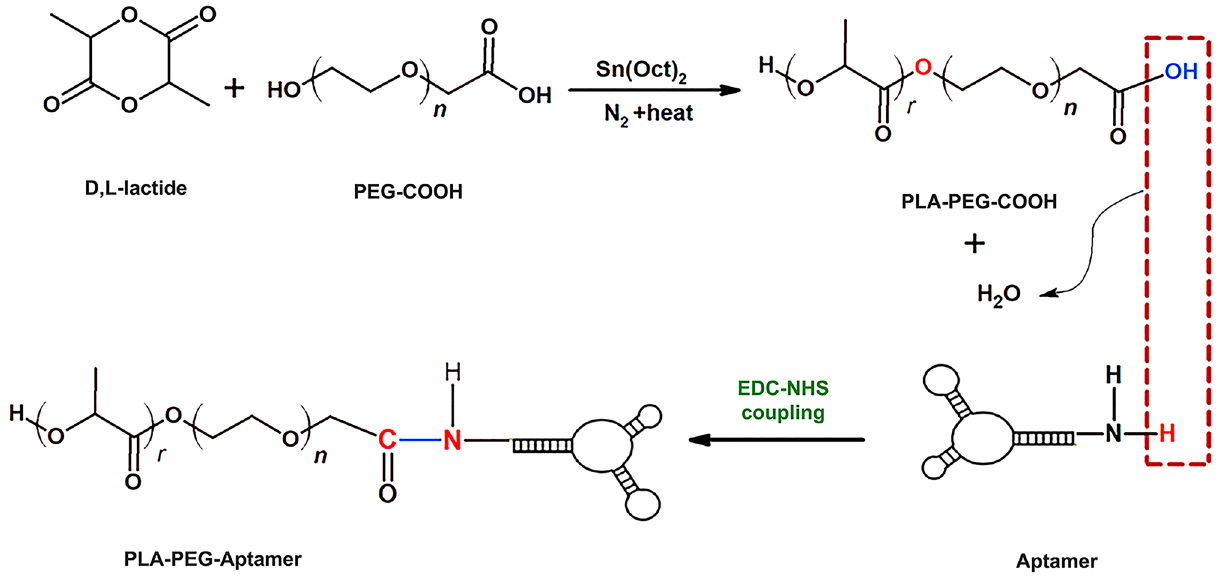
Figure 1. Schematic illustration of synthesizing PLA-PEG–COOH and preparing aptamer conjugated